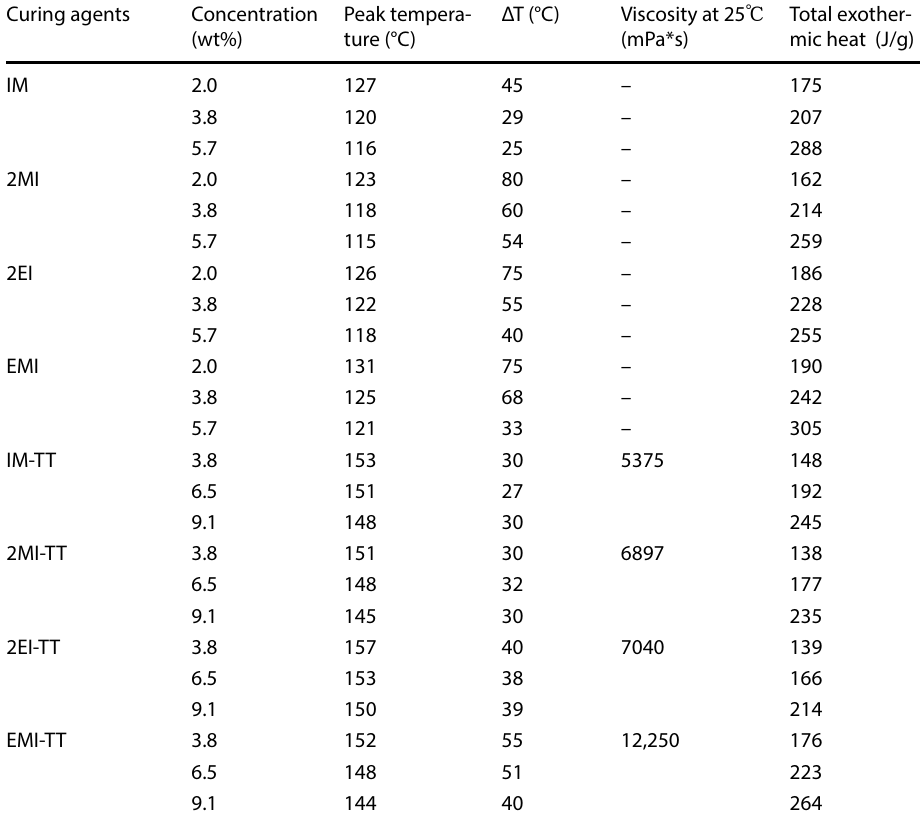
Table 1 The exothermic parameters of the EP blends